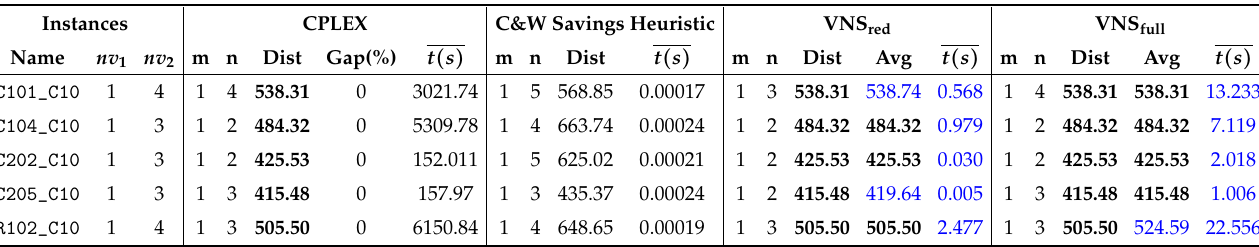
Table 6. Computational results for small-sized instances with 10